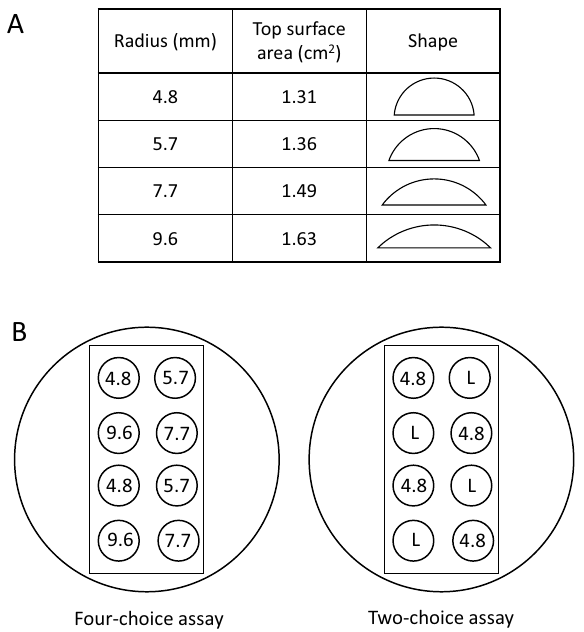
Figure 1. Schematic representation of the experimental setups. ( A ) Shape of the oviposition substrates. ( B ) Arrangement of the oviposition substrates in the oviposition assay. In a disposable petri dish, a piece of cotton pad was placed and soaked with water. Eight oviposition substrates were put on the cotton pad. “L” in two- choice assay designates oviposition substrates with either of 5.7, 7.7, or 9.6 mm